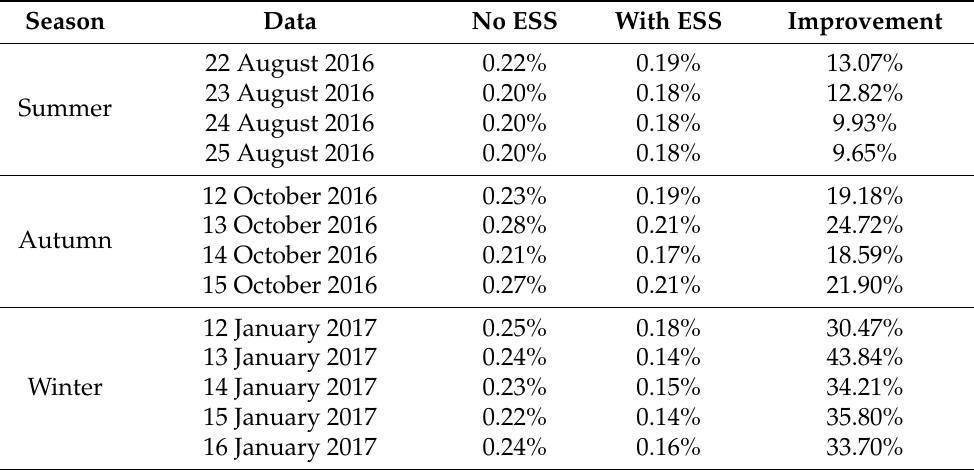
Table 1. Maximum PVUR improvement from ESS controller.